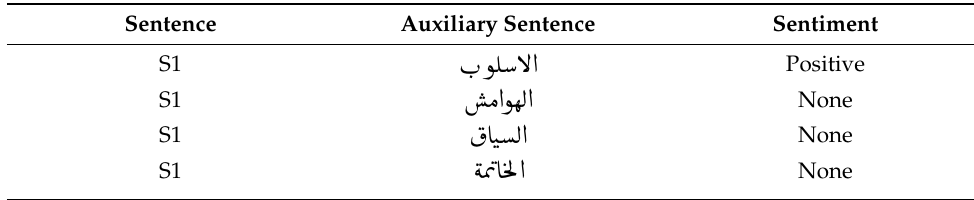
Table 3. An example of the HAAD dataset with the NLI-M method for S1.